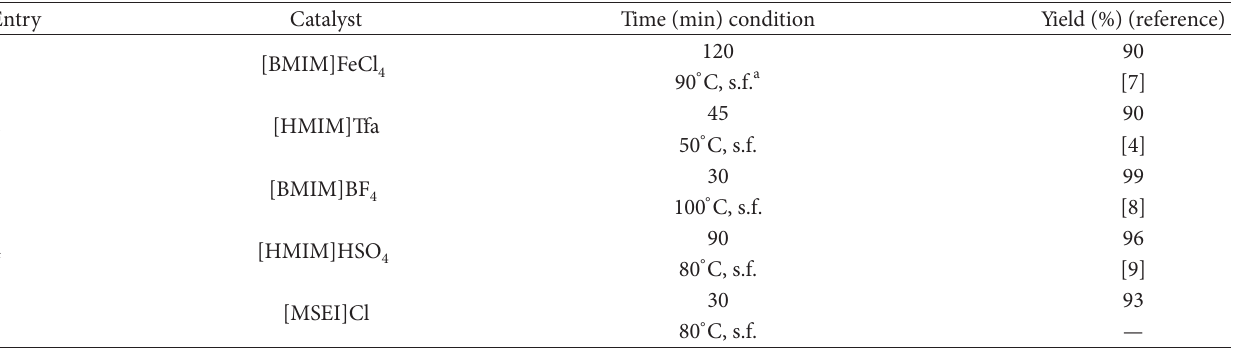
T 3: Comparison of catalytic ability of